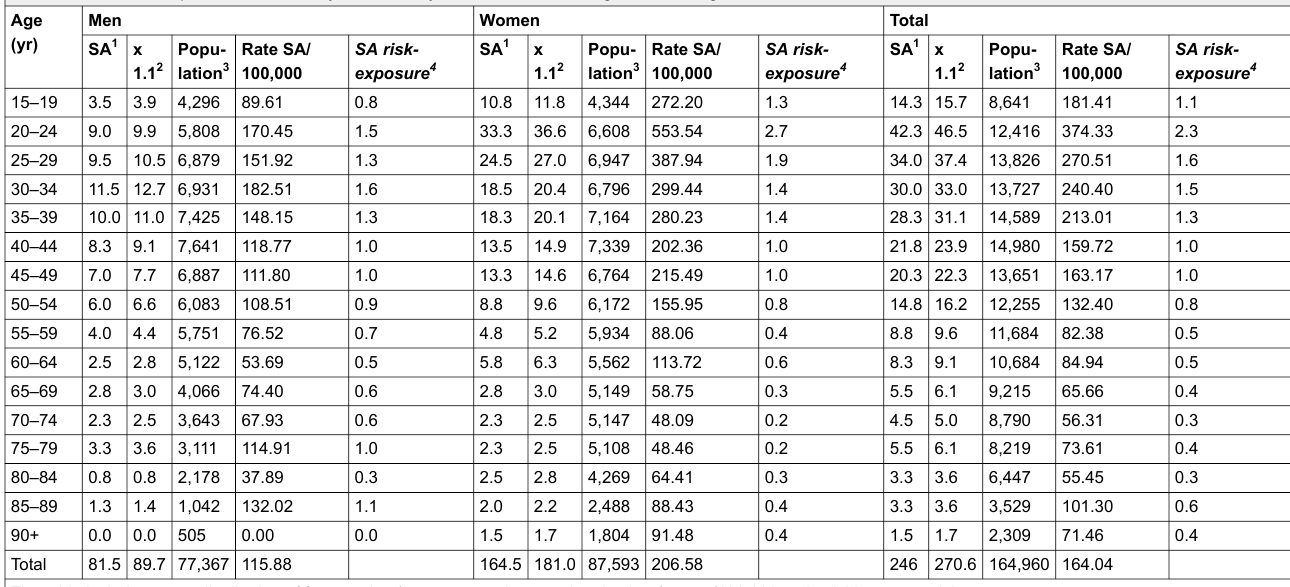
Table 1: Suicide attempt rates in the county of Basel-City, 2003–2006, according to sex and age. Men Women TotalAge (yr) SA 1